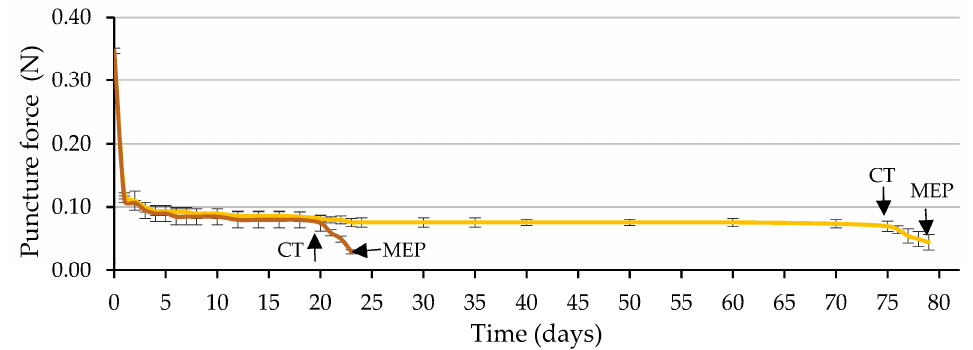
Figure 9. Time courses of endosperm weakening measured by the puncture force required to pierce the micropylar endosperm (ME) during the germination test, using a GA 3 solution (500 mg L − 1 , in brown) or water (in yellow) to wet the substrate prior to ME piercing (MEP) by the radicle (3 days after testa cracking). The arrows indicate the dates on which the cracking of the testa (CT) and MEP occurred. Up to each CT, the values correspond to seeds with uncracked testa and from CT to seeds with cracked testa (prior to MEP by the radicle). Average values of four replicates of 10 seeds each. Vertical bars represent the standard error.